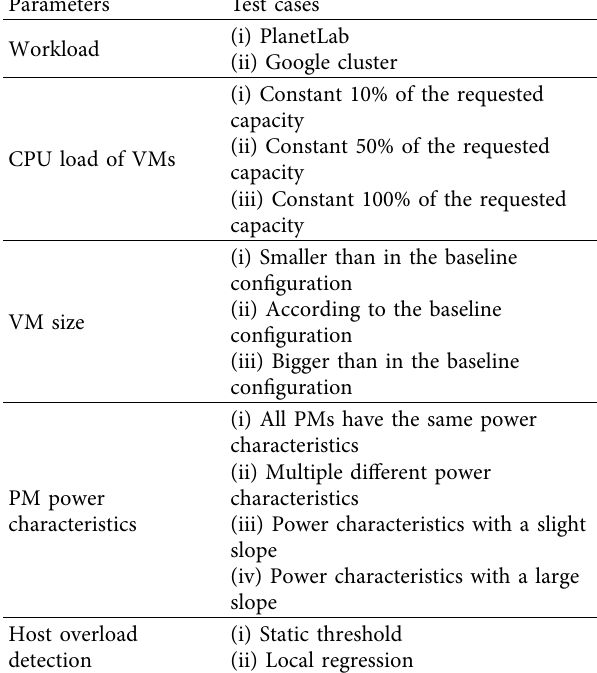
Table 2: Overview of the parameters considered for conducted experiments.